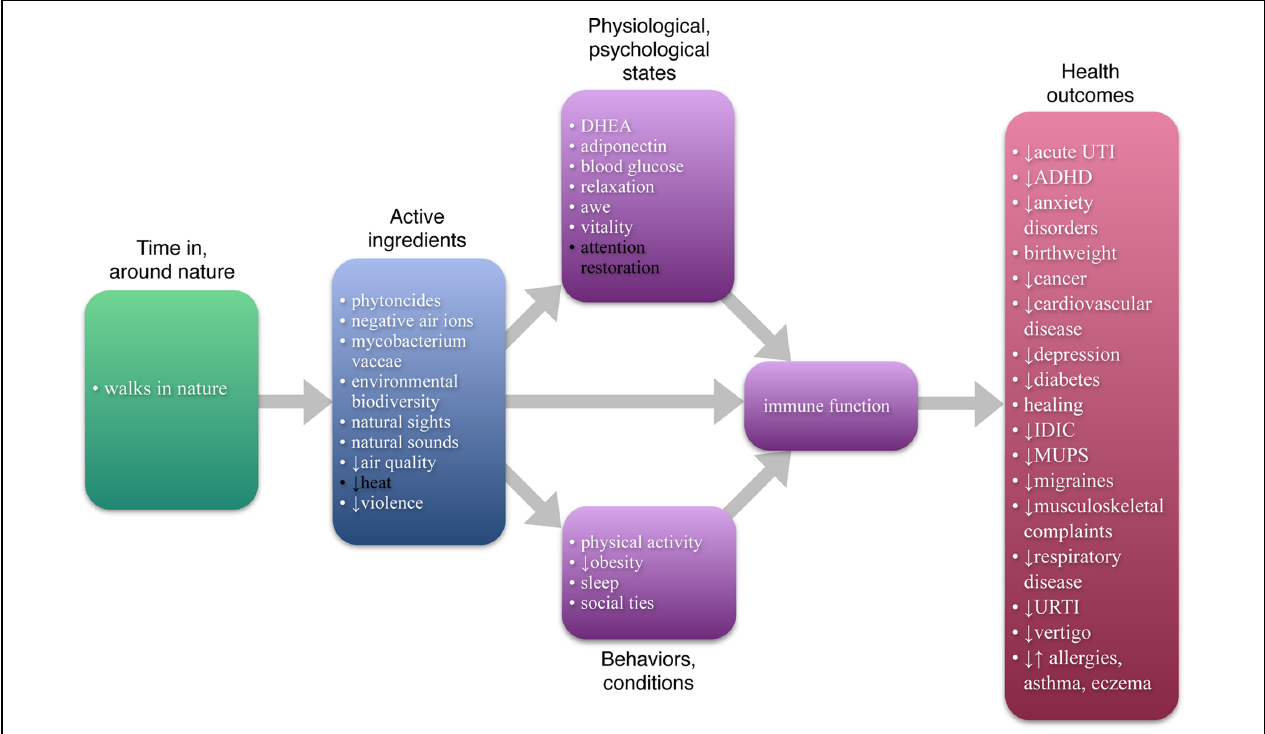
FIGURE 2 | Enhanced immune function as one possible central pathway. All items in white text are currently known or have been proposed to be causally tied to immune function. As the Figure shows, enhanced immune function can account, at least partially, for